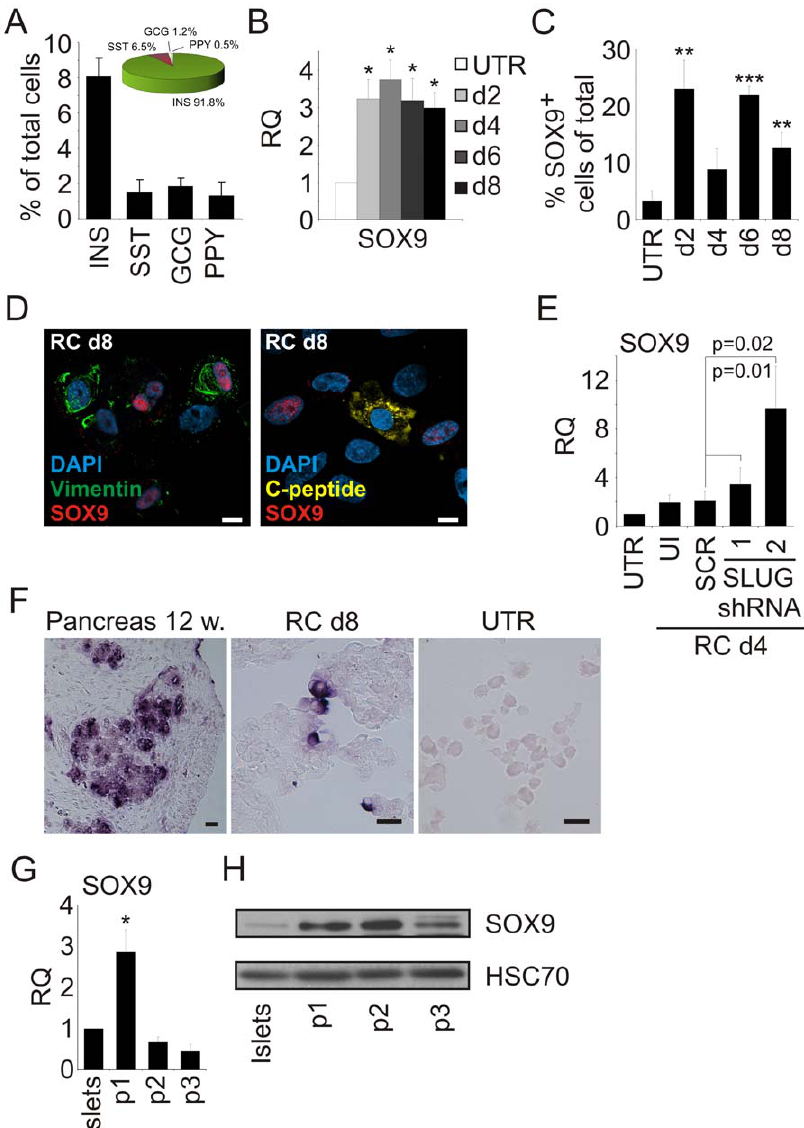
Figure 5. BCD cell redifferentiation involves expression of pancreas- and islet-progenitor transcription factors SOX9 and NGN3, respectively. A: RC treatment of expanded islet cells (p6) results in generation of hormone-expressing cells other than insulin. Cells were treated with RC for 8 days and stained with antibodies for the indicated hormones (insulin-producing cells were identified by staining for C-peptide). Values are mean 6 SE (n=4 donors), based on counting . 500 cells from each donor. The inset pie-chart depicts the percent of cells positive for each hormone among a total of 1736 hormone-positive eGFP + cells scored in parallel experiments with lineage-traced cells from 6 donors. B–D: SOX9 activation during redifferentiation. Islet cells at p5 were treated with RC for 8 days. B: qPCR analysis of kinetics of upregulation of SOX9. Values are mean 6 SE, relative to untreated cells (d0) (n=4 donors), and normalized to human RPLPO or GAPDH. *p , 0.05. C: Quantitation of SOX9 + cells by immunofluorescence analysis. Values are mean 6 SD, based on counting . 500 cells from each of 3 donors at each time point. **p # 0.01, ***p # 0.001, relative to untreated cells (d0). D: Left, Immunofluorescence analysis detects cells stained for vimentin or SOX9 alone, as well as double-positive cells. Right, C-peptide and SOX9 staining is mutually exclusive. Bar=10 m m. E: qPCR analysis of SOX9 transcripts in expanded islet cells at p5 transduced with lentiviruses expressing one of two SLUG shRNAs or a scrambled shRNA and treated with RC for 4 days. Values are mean 6 SE relative to untreated cells (n=4–6 donors) and normalized to human RPLPO or GAPDH. UI, uninfected cells treated with RC. F: NGN3 is activated during redifferentiation. In-situ hybridization analysis of NGN3 mRNA expression in human fetal pancreas cells (left panel) and expanded islet cells at p5 following 8d treatment with RC treated islet cells (right panel). Bar=25 m m. G–H: Transient activation of SOX9 during islet cell dedifferentiation. G: qPCR analysis of expanded islet cells at the indicated passages. Values are mean 6 SE relative to uncultured islets (n=3 donors) and normalized to human RPLPO. *p , 0.05. H: Immunoblotting analysis of protein extracted from uncultured islets and expanded islet cells at the indicated passage number. following RC treatment (data not shown), suggesting that the a transient activation of SOX9 during redifferentiation and MET. expanded islet cells did not give rise to duct- or acinar-like cells. SOX9 transcript levels were stimulated 5-fold by SLUG shRNA Expression of NGN3 , a marker of islet progenitor cells, could not (Figure 5E), suggesting that SOX9 expression is downstream of be reproducibly detected by qPCR during redifferentiation. MET. CK19- or amylase-positive cells could not be detected